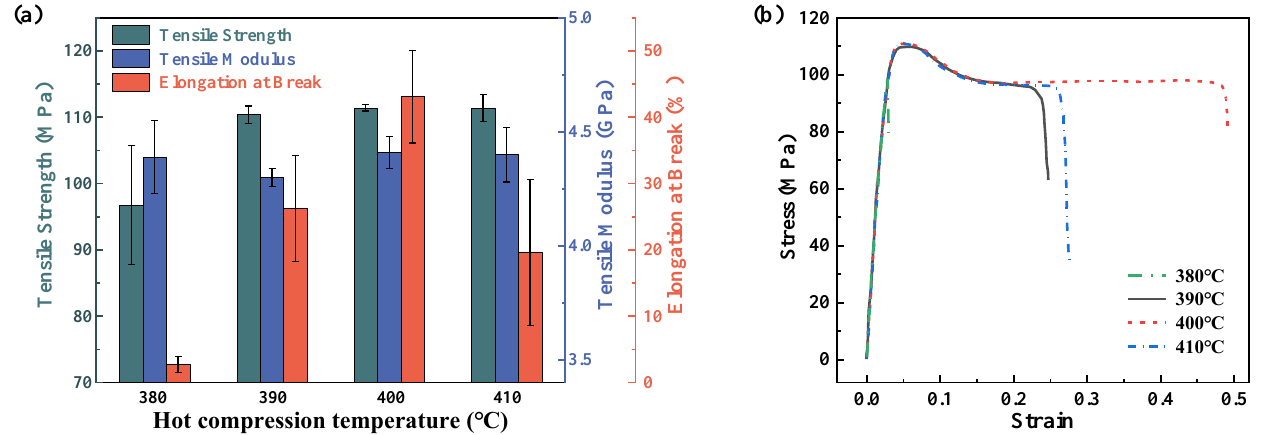
Figure 4. Tensile mechanical performance of PEEK plates under different processing temperatures.